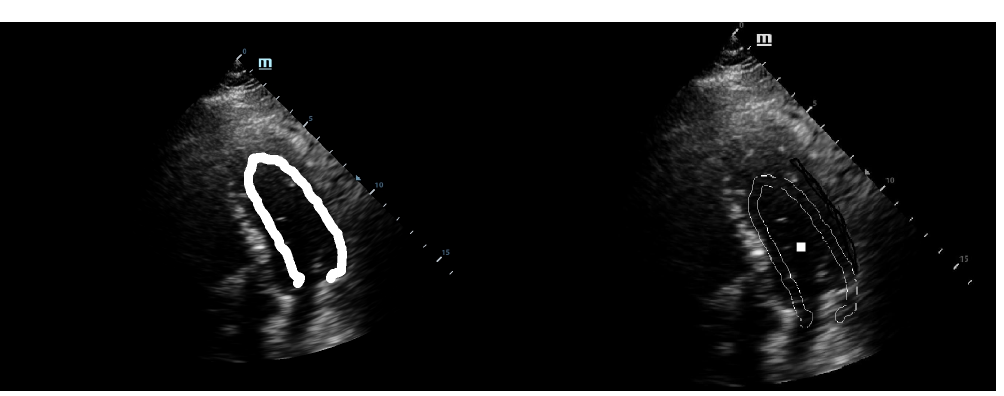
Figure 2. Direct application of the anisotropic Hough